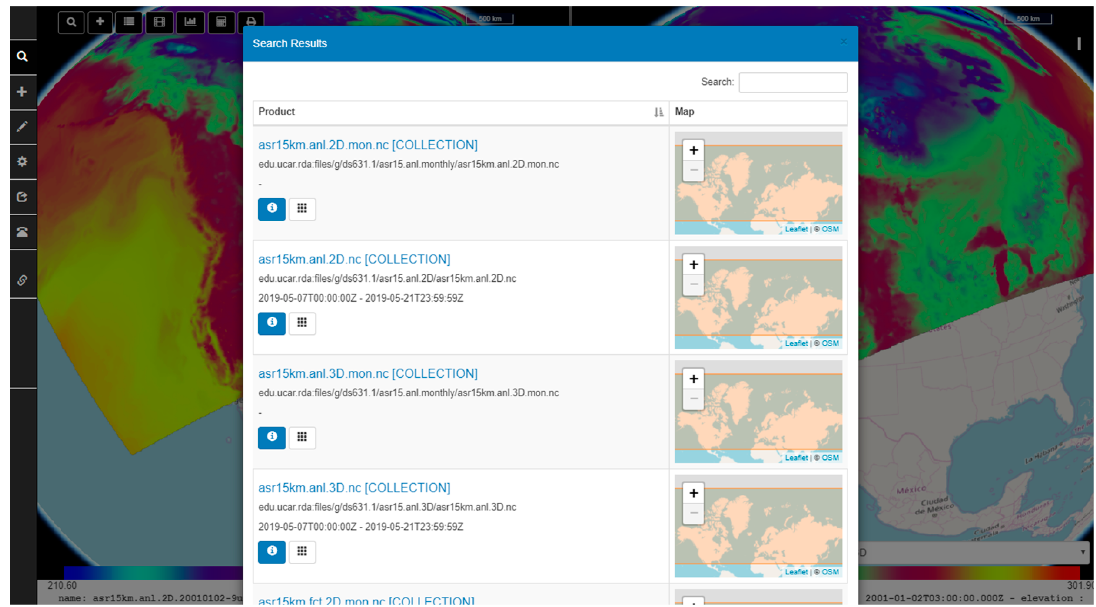
Figure 15. ASR (Arctic System Reanalysis) search results and visualization of the temperature at 2 m above the surface in the CyberConnector COVALI visualization system.